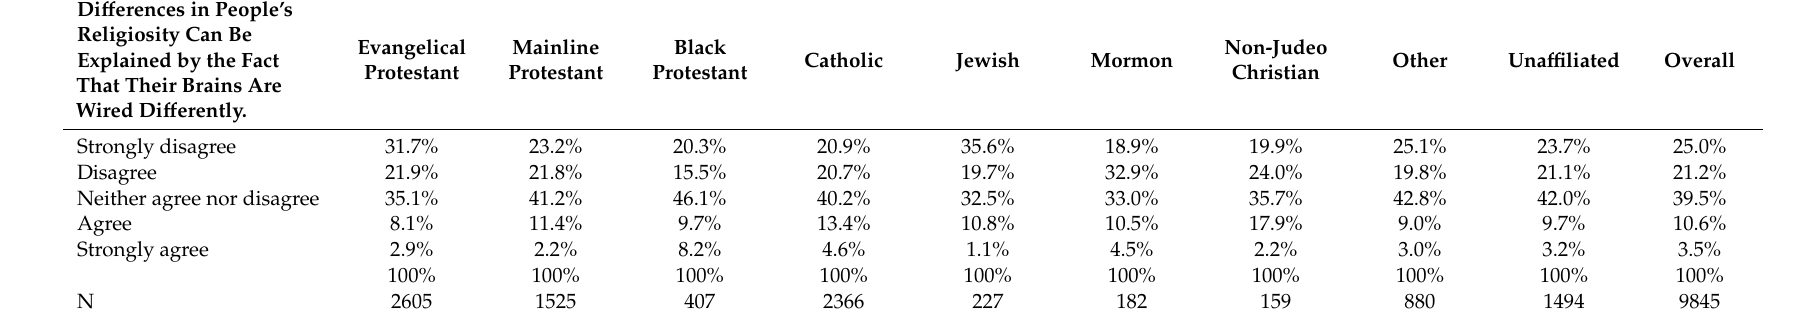
Table 2. Attitudes about Brain Wiring Explaining Religiosity by Religious Tradition.